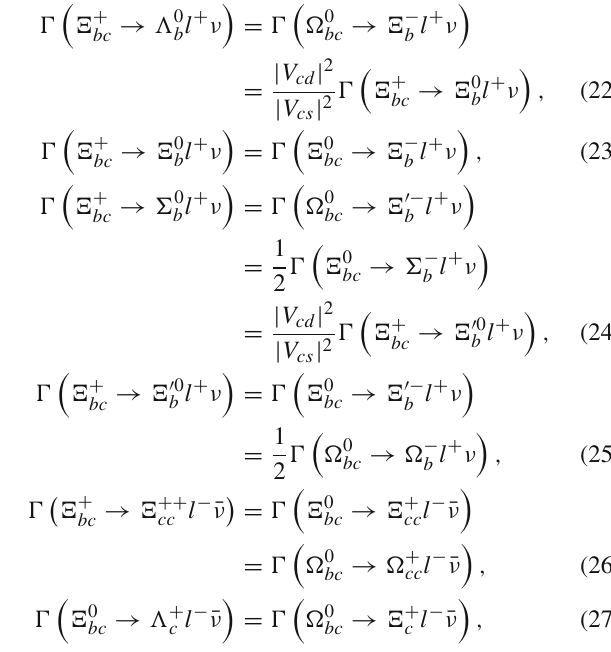
ment, T cc → T bc , T c → T b . The replacement in